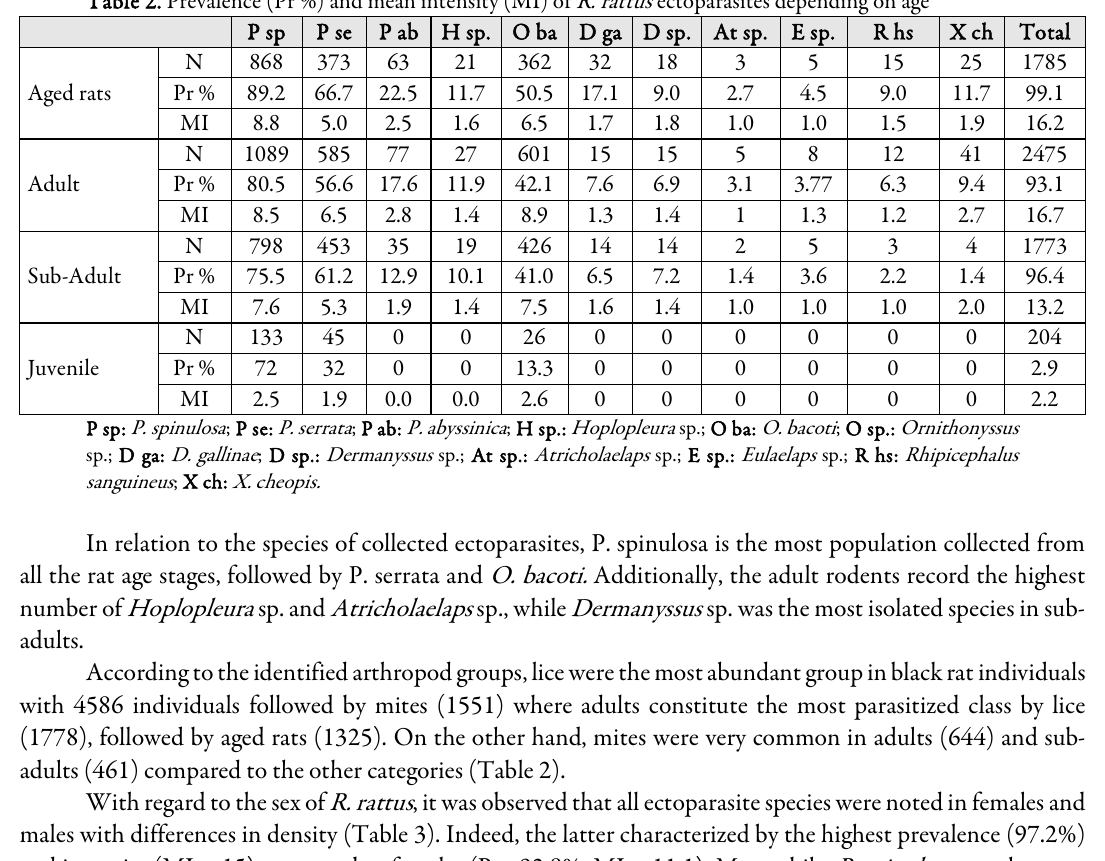
Figure 1. Most captured ectoparasites in R. rattus (a: Polyplax spinulosa ; b: P. serrata ; c: Ornithonyssus bacoti ) Prevalence and mean intensity of ectoparasites